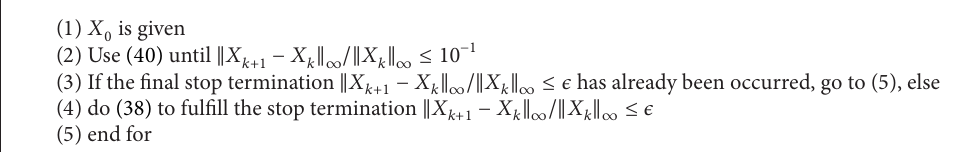
Algorithm 2: The hybrid algorithm for computing matrix sign